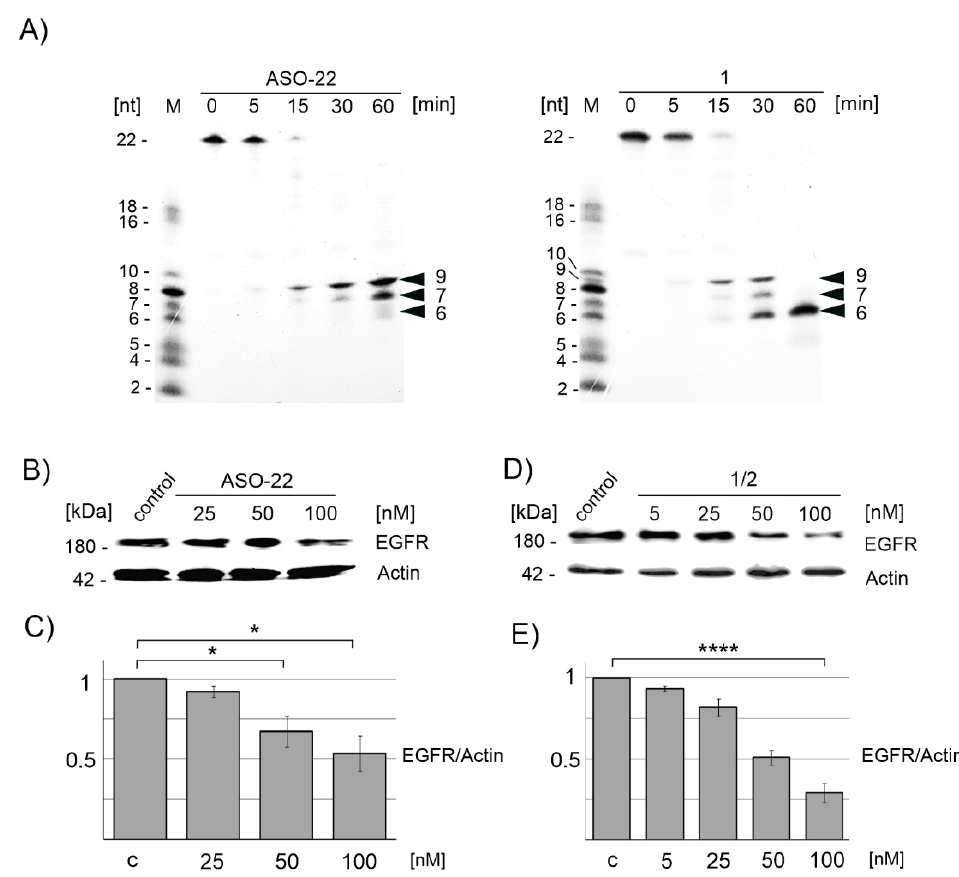
Figure 3. Cleavage of the [ 32 P]-RNA target fragment of the EGFR gene hybridized with triped 1 and with ASO-22 monitored electrophoretically (PAGE) under in vitro conditions in the presence of recombinant RNase H ( A ); silencing activity of ASO-22 and 1/2 towards the endogenous mRNA of EGFR protein in A431 cancer cells analyzed by immunoblot imaging (( B , D ), respectively) and quantified in the plot ( C ) * p ≤ 0.05 and ( E ) **** p ≤ 0.0001 (ANOVA and post-hoc Tukey HSD test), respectively. A431 cells transfected with ASO-C are the control and M is the 32 P-isotope labeled mixture of oligoribonucleotides (2–22 mers).